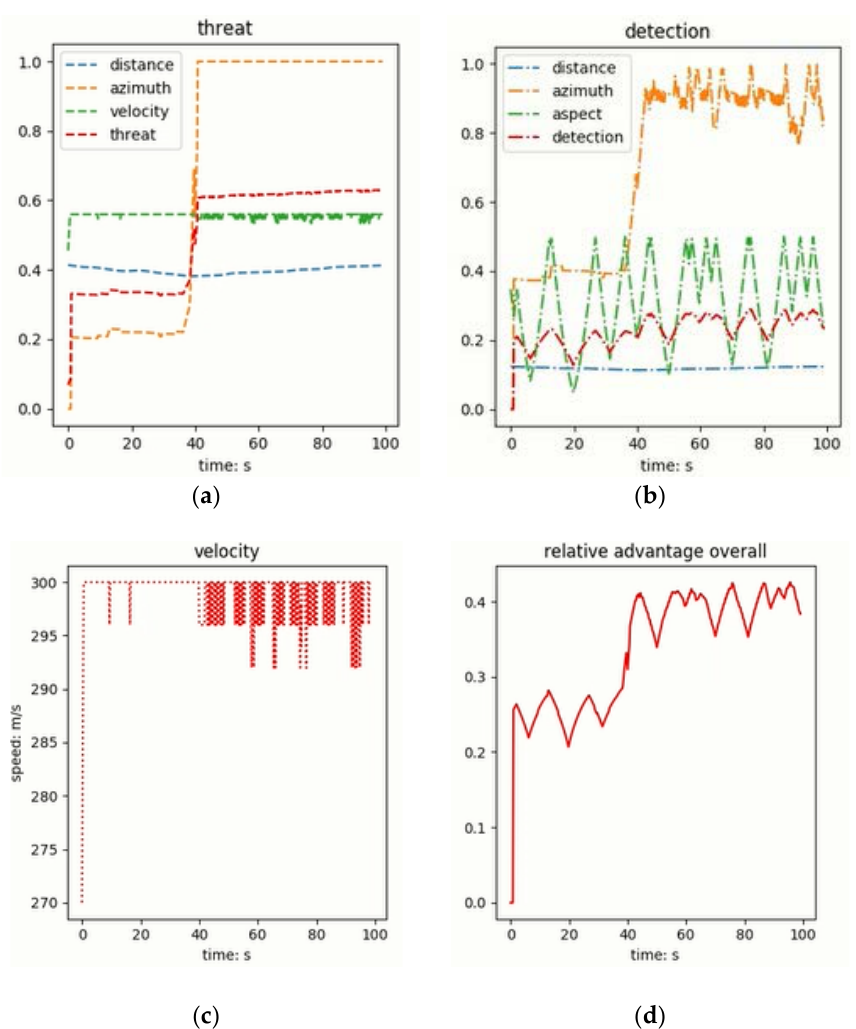
Figure 12. 2D balance: native data change: ( a ) Threat ability; ( b ) Detection ability; ( c ) Speed; ( d ) Relative advantage.